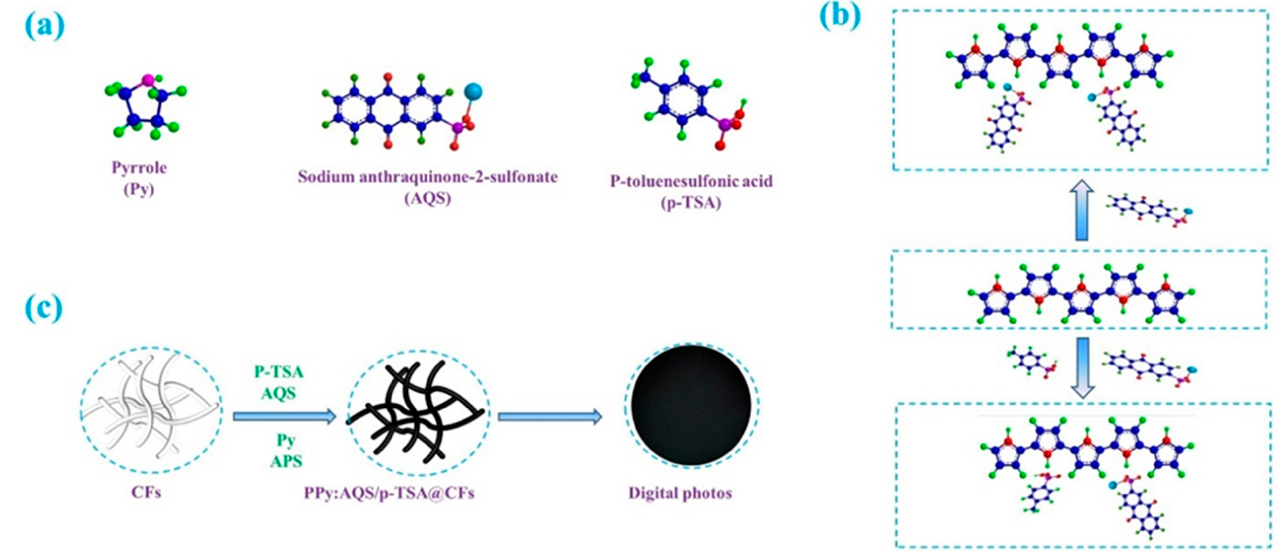
Figure 1. Ball-and-stick models of monomer Py, dopants AQS, and p-TSA, ( a ); doping mechanism diagram of PPy:AQS/p-TSA@CFs electrode materials, ( b ); and schematic diagram of the preparation process of PPy:AQS/p-TSA@CFs paper electrode materials, ( c ).